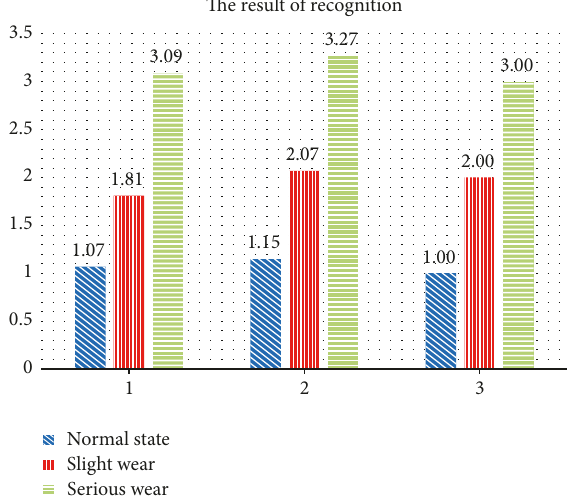
Figure 5: Comparison of output results and training standards.